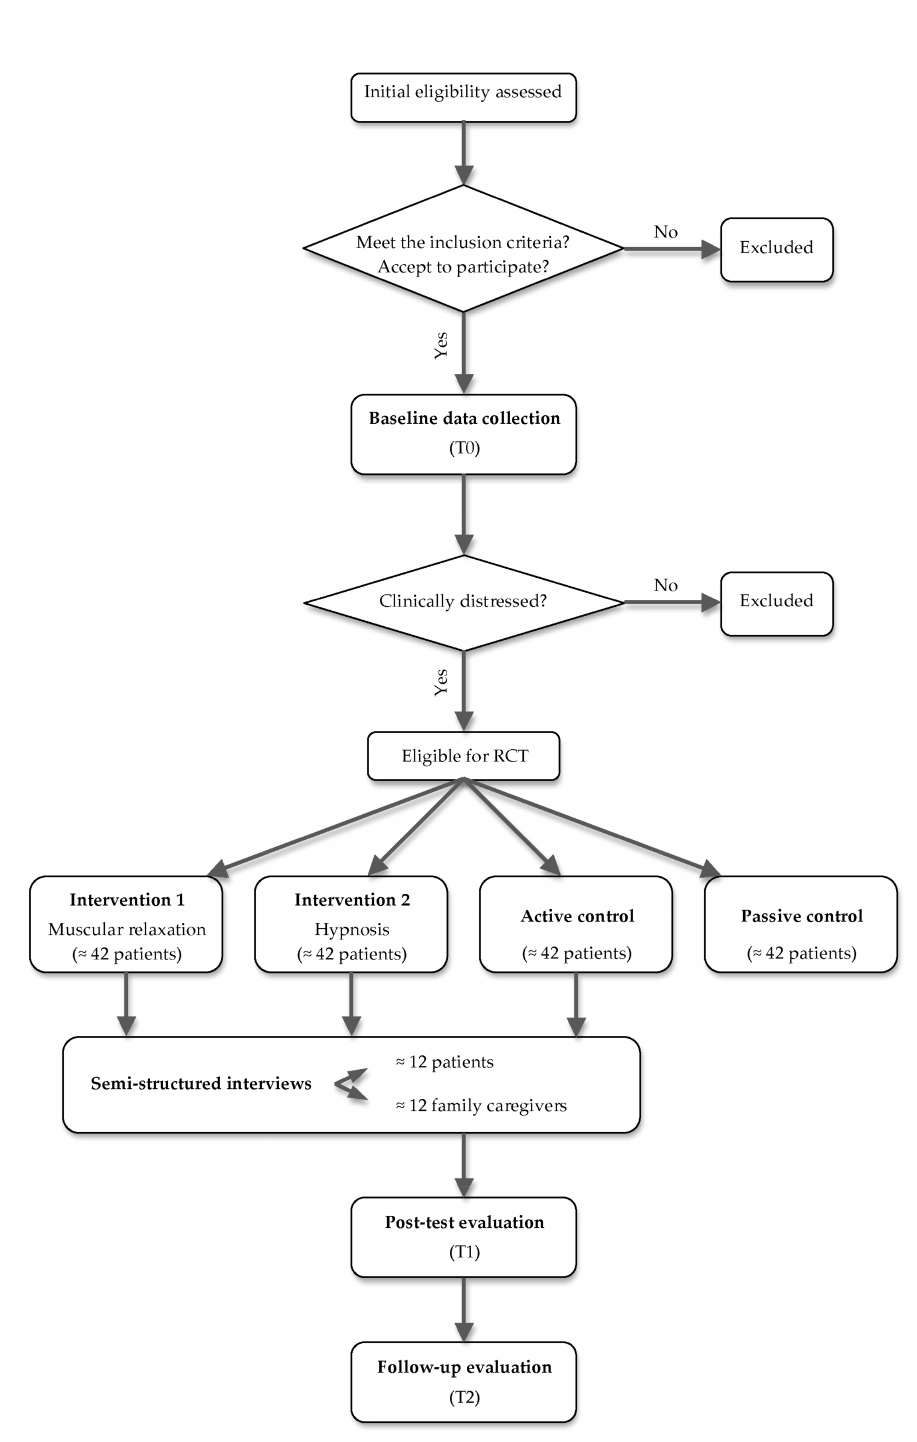
Figure 1. Study design and CONSORT flow